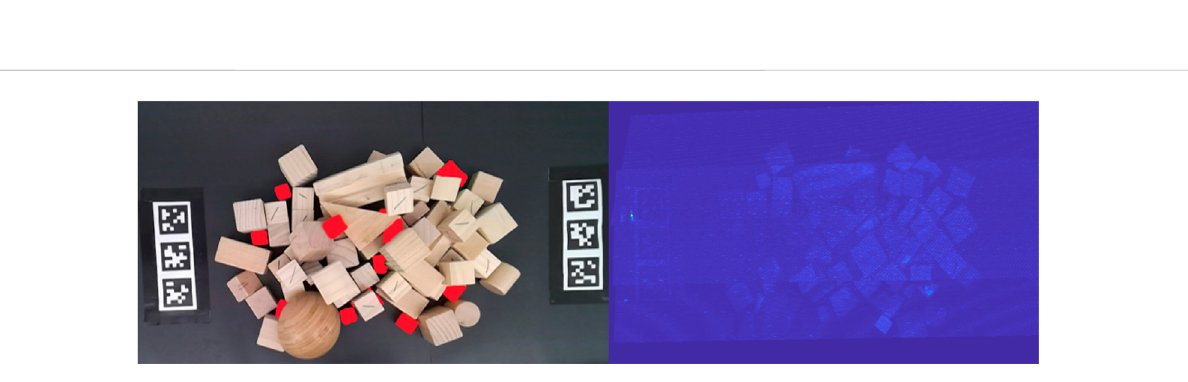
FIGURE 4 The blocks labeled with red highlights showing ground truth regions that should be detected as anomalous and distinct from the background. When using RX as the statistical anomaly detector, the colorized outline scores are shown on the right. The RX outlier detector fails to distinguish anomalous regions from the pure wooden